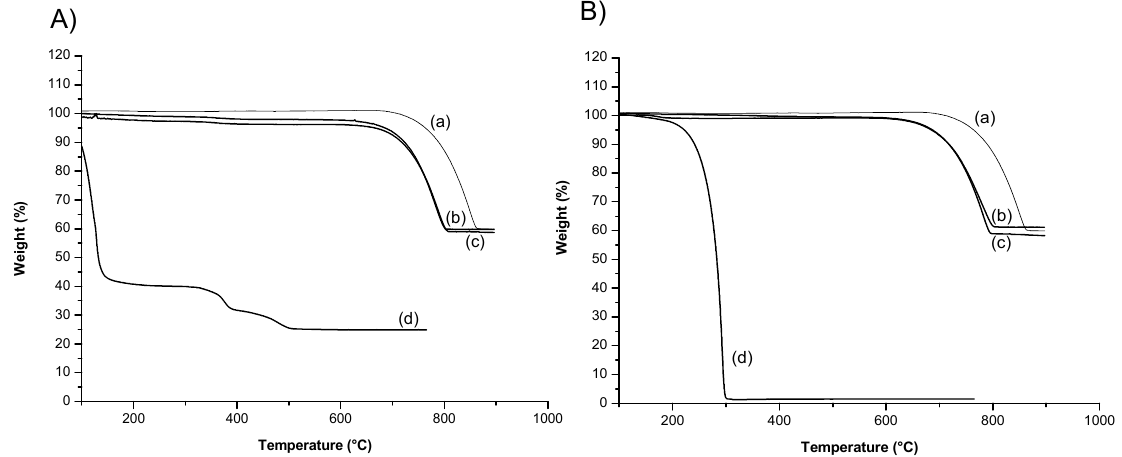
Figure 8. TGA curves of: ( A ) (a) CD-CaCO 3 , (b) CD-PVSA_30mM_10min, (c) CD-PVSA_30mM_4h, (d) PVSA and ( B ) (a) CD-CaCO 3 , (b) CD-glycerol_4mM_10min, (c) CD-glycerol_4mM_4h, (d) glycerol.